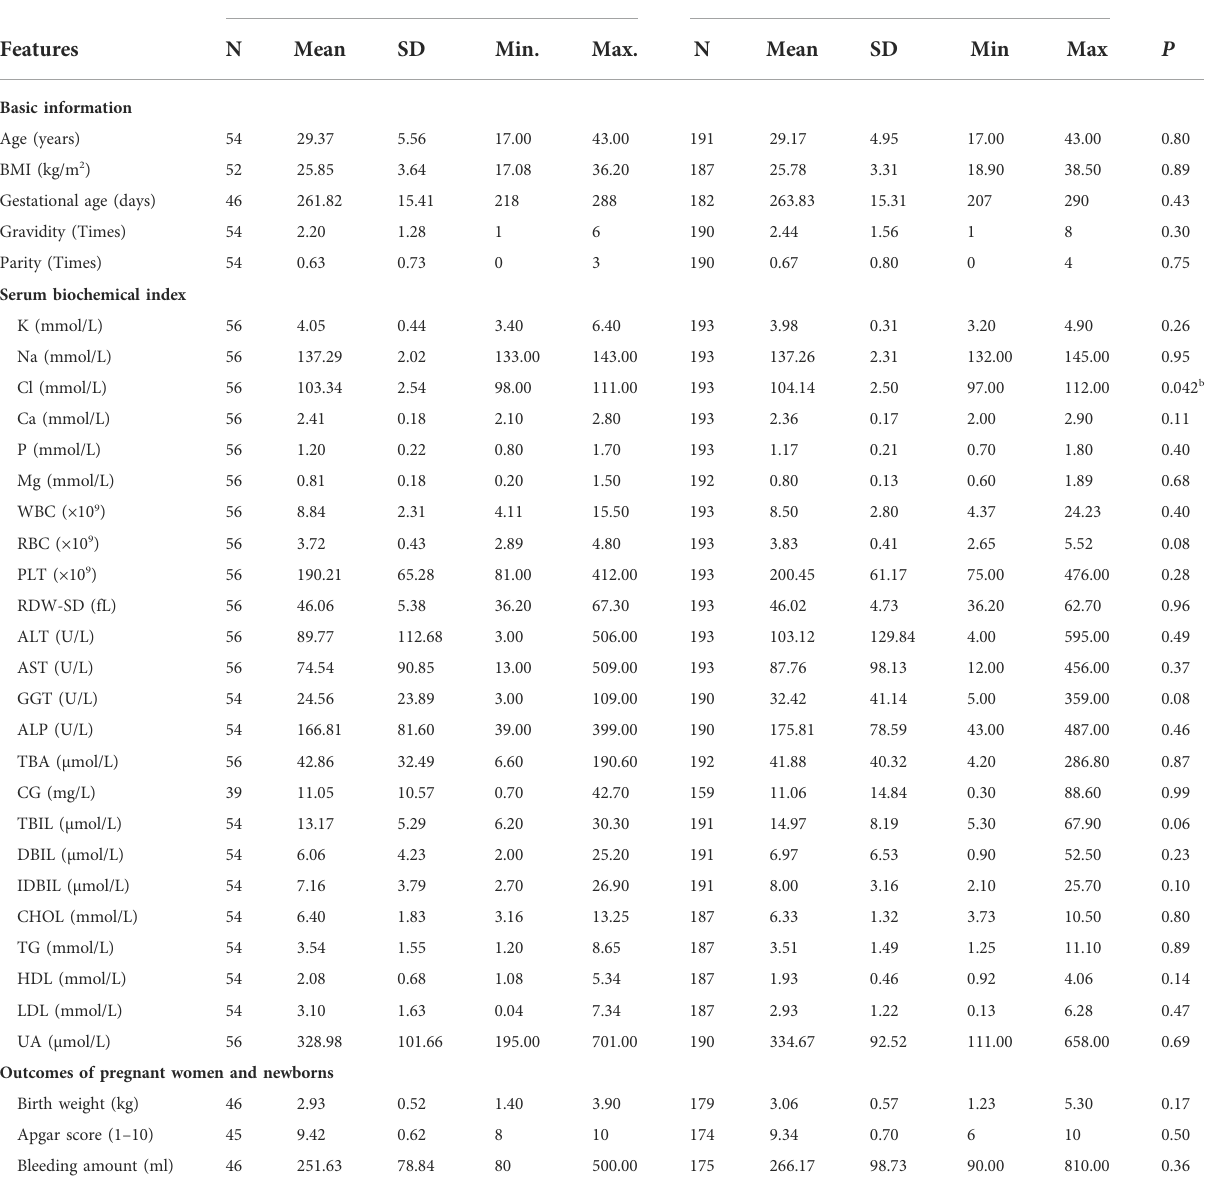
TABLE 3 Descriptive statistics of 32 clinical features of ICP individuals associated with/without 62 novel mutations a . ICP with 62 novel mutations ICP without 62 novel